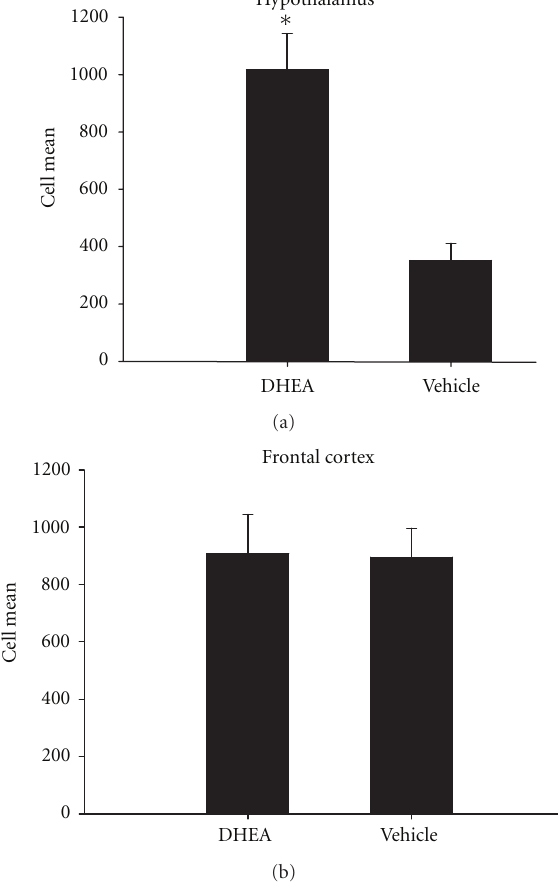
Figure 2: Mean number of GABA A alpha-4 subunit transcript copies per cell in the hypothalamus (top panel) and frontal cortex (bottom panel) of rats administered 56mg/kg of DHEA or vehicle. Drug-na¨ıve male rats received either DHEA ( n = 12) or an equal volume of cyclodextrin vehicle ( n = 12) for ten consecutive days; on the tenth day, subjects were sacrificed and their brains were collected. Brains were dissected using the Glowinski technique [75], and each brain region was pooled and homogenized. Due to the high lipid content of the samples, a spin column technique was utilized for the RNA extraction. RNA analysis was performed using TaqMan assay kits (Applied Biosystems, Foster City, Calif, USA). Approximately 1 to 2 μ L of each sample were used to determine the RNA concentration in each sample using Nanodrop. Values are expressed as a fraction of a normalizing gene, ribosomal 18S